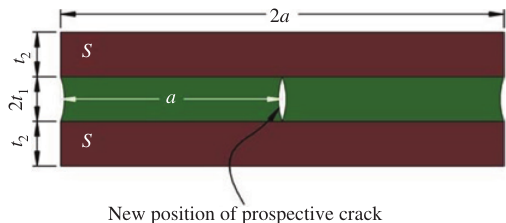
Figure 4: Different region of the delaminated unit